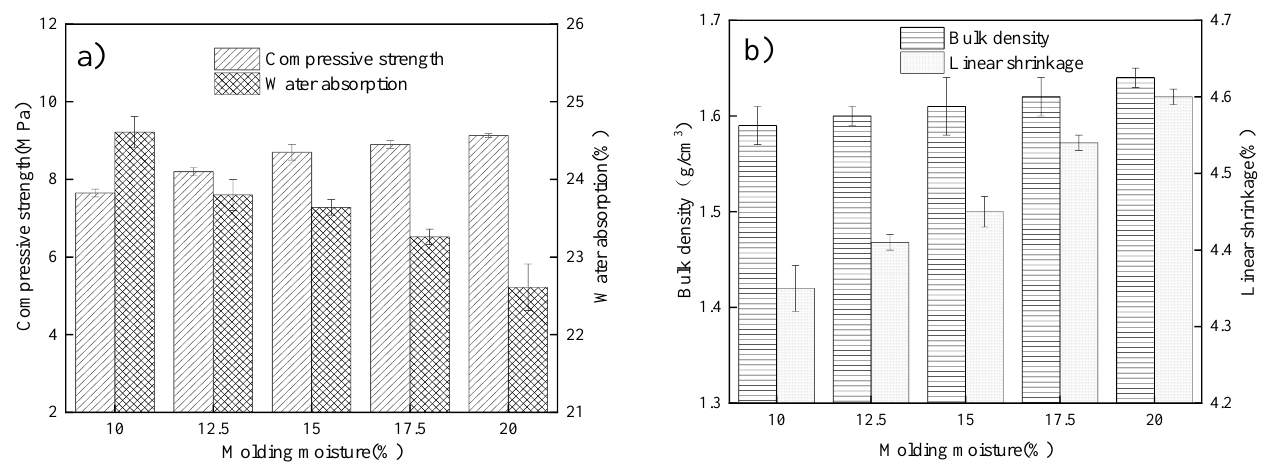
Figure 7. Effect of molding moisture on the characteristics of sintered brick: ( a ) compressive strength and water absorption; ( b ) bulk density and sintering shrinkage.